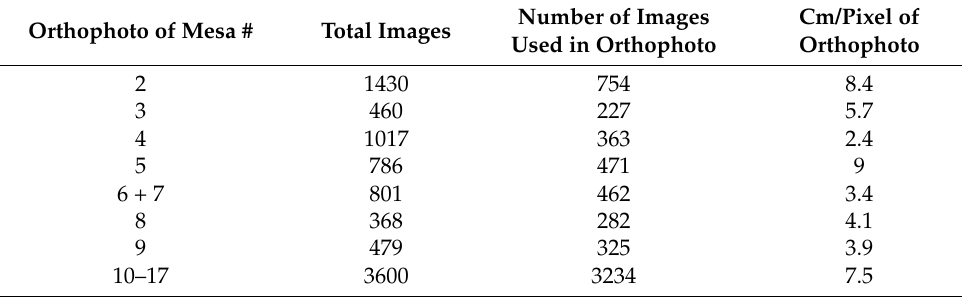
Table 2. Details of the orthophotos used in the analysis.